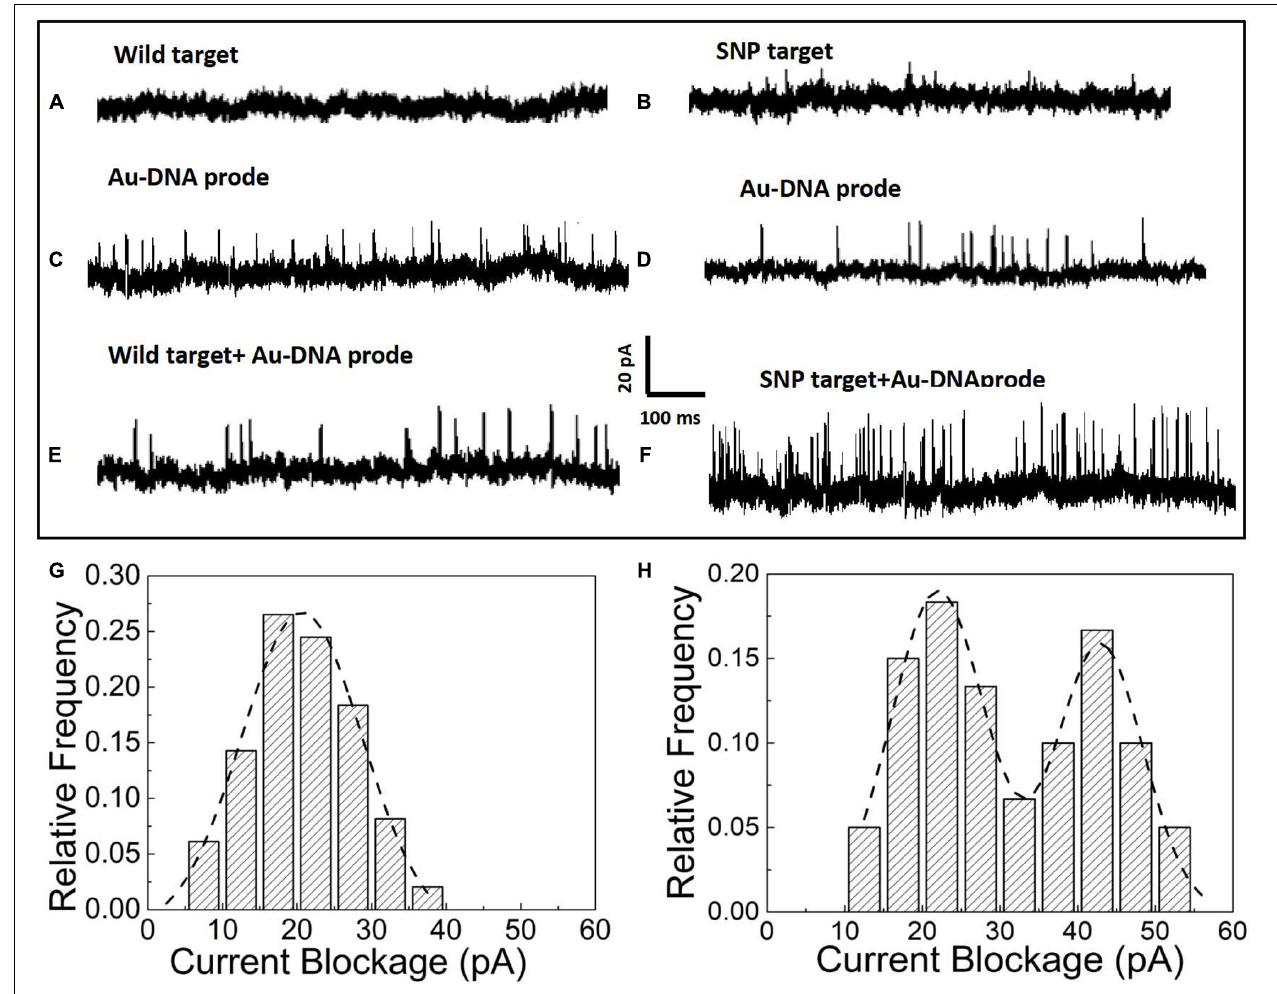
FIGURE 2 | (A) Current signal in the presence of wild targets. (B) Current signal in the presence of SNP targets. (C) Current signal in the presence of the Au-DNA probe. (D) Current signal in the presence of Au-DNA probes. (E) Current signal in the presence of wild targets with Au-DNA probes. (F) Current signal in the presence of SNP targets with Au-DNA probes. (G) Histograms of the blocked current amplitudes with wild targets. (H) Histograms of the blocked current amplitudes with SNP